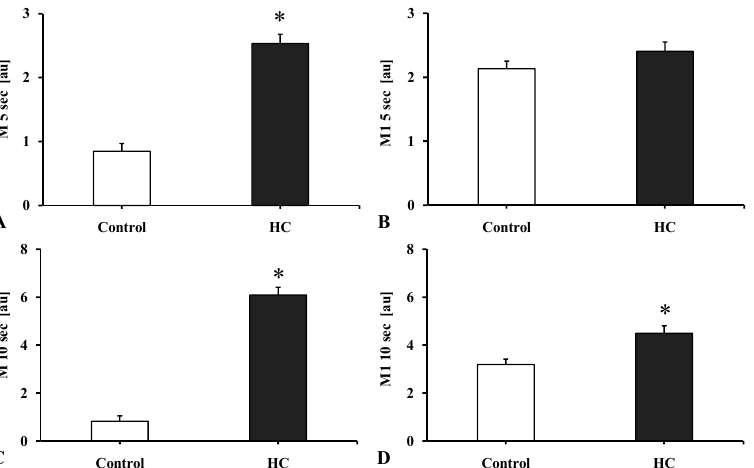
Figure 2. The red blood cell aggregation indices ( A ): M 5 s, ( B ): M1 5 s, ( C ): M 10 s, ( D ): M1 10 s [au]) measured by the Myrenne MA-1 aggregometer in the Control and the atherogenic group (HC). In M mode (shear rate = 0 s − 1 ) and M1 mode (shear rate = 3 s − 1 ) the index values are expressed at the 5th or at the 10th second of the aggregation. Means ± SEM; * p < 0.05 vs. Control.